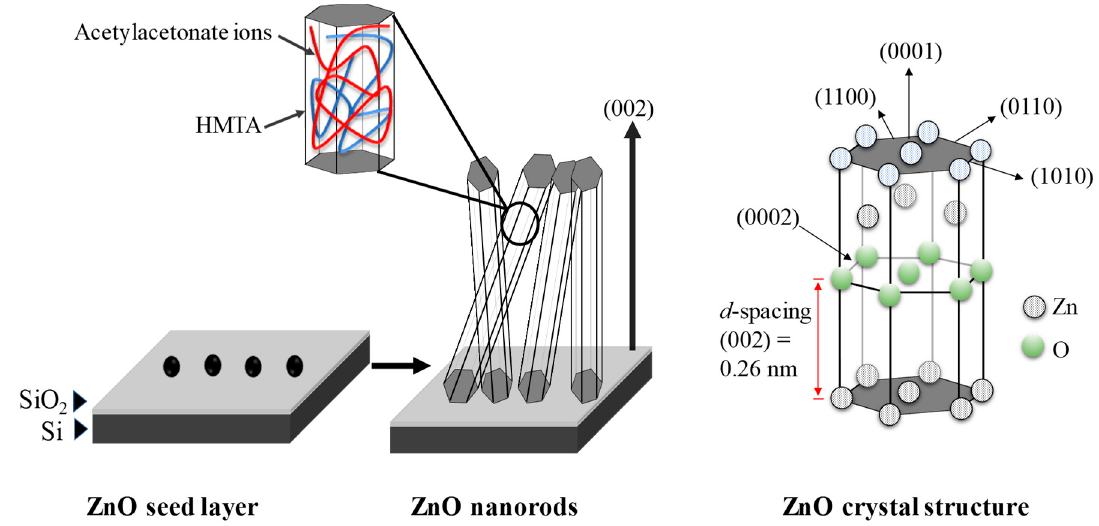
Figure 5. Schematic illustration of the possible growth mechanism of the ZnO NRs synthesized using the acetylacetonates-assisted hydrothermal the acetylacetonates-assisted hydrothermal method.